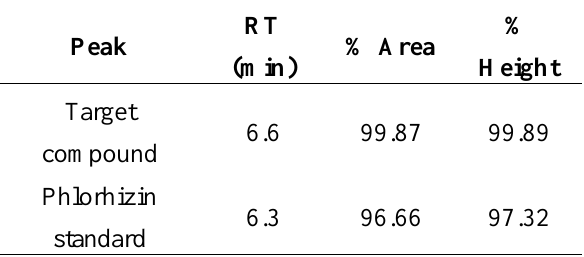
Table 1. HPLC data of the target compound and a phlorhizin